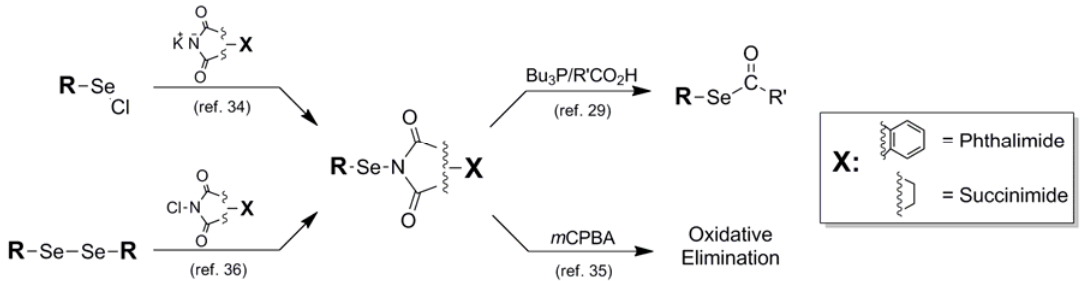
Figure 8. Synthetic routes into Phthalimide and Succinimide protection schemes and their routes for